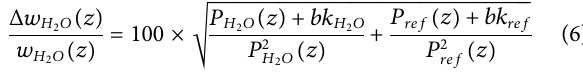
Frontiers in Remote Sensing |